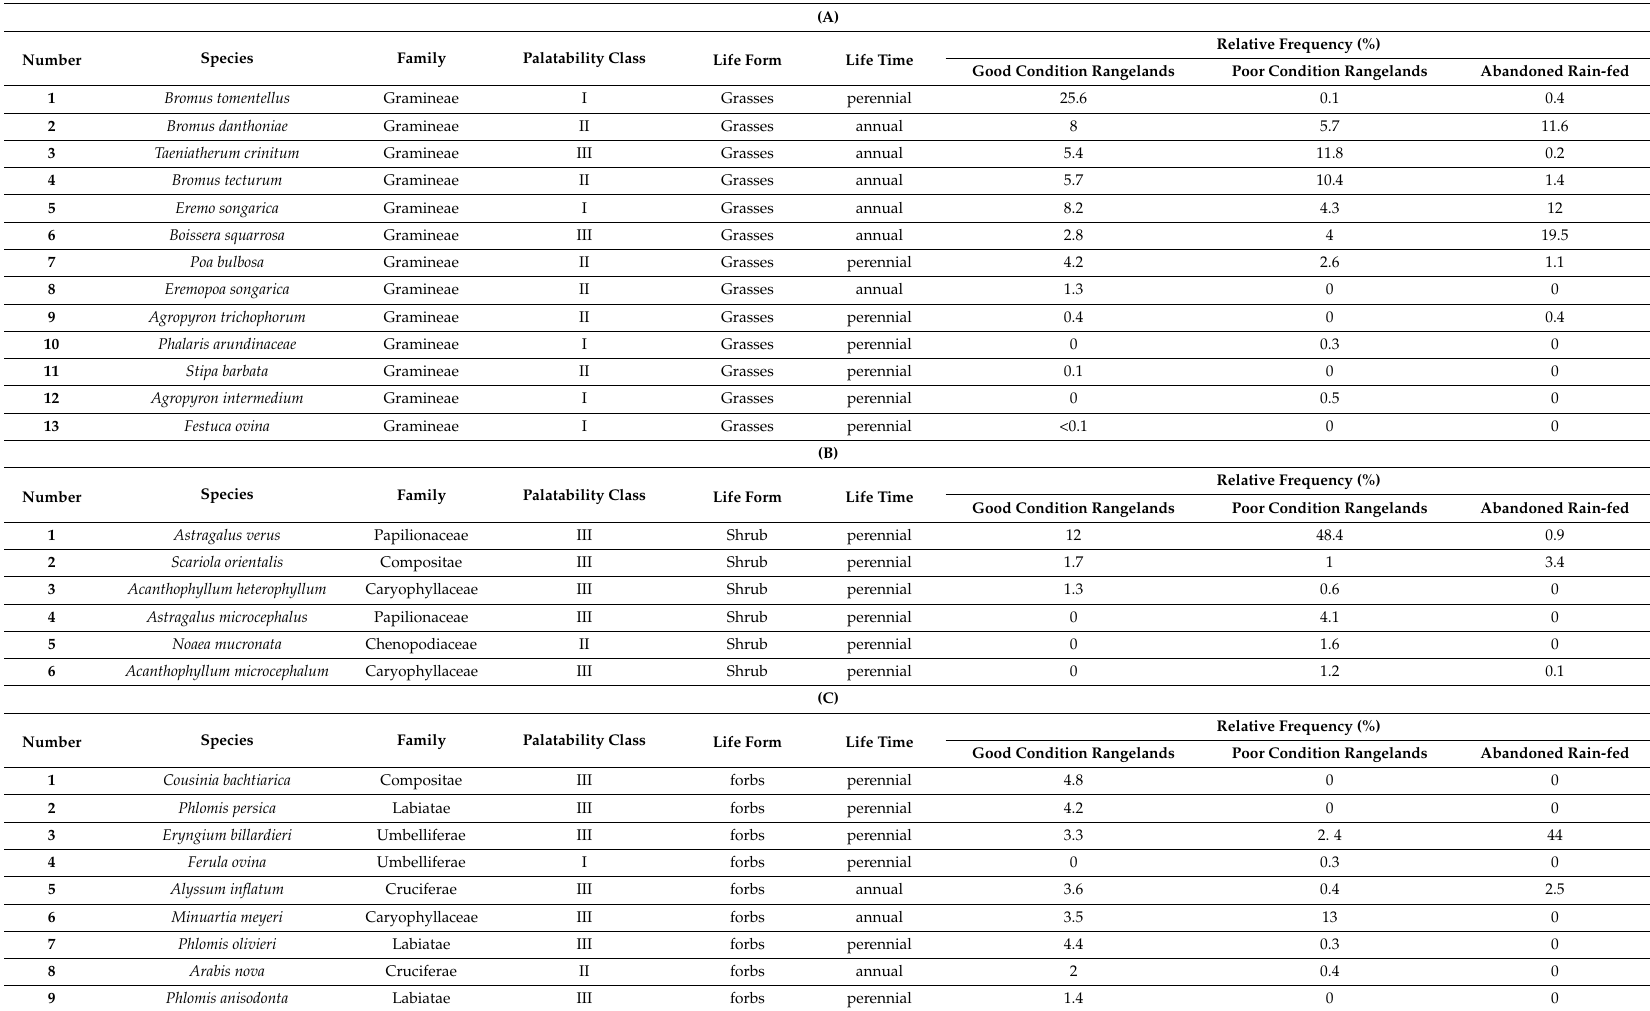
Table 4. Floristic list of the studied region (grasses ( A ), shrub ( B ), and forbs( C ))